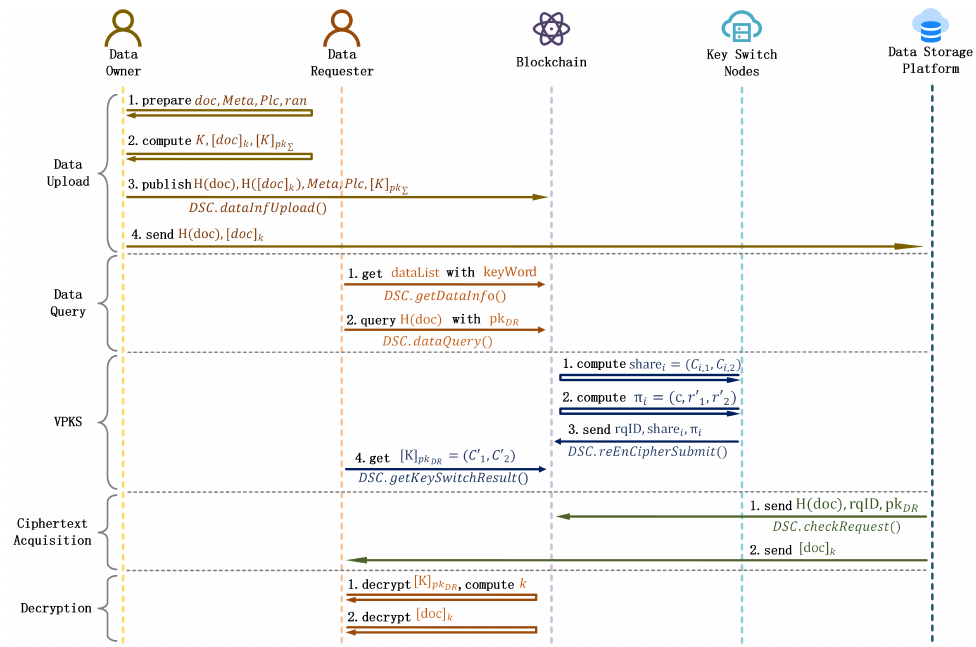
Figure 4. An illustration of the proposed data sharing